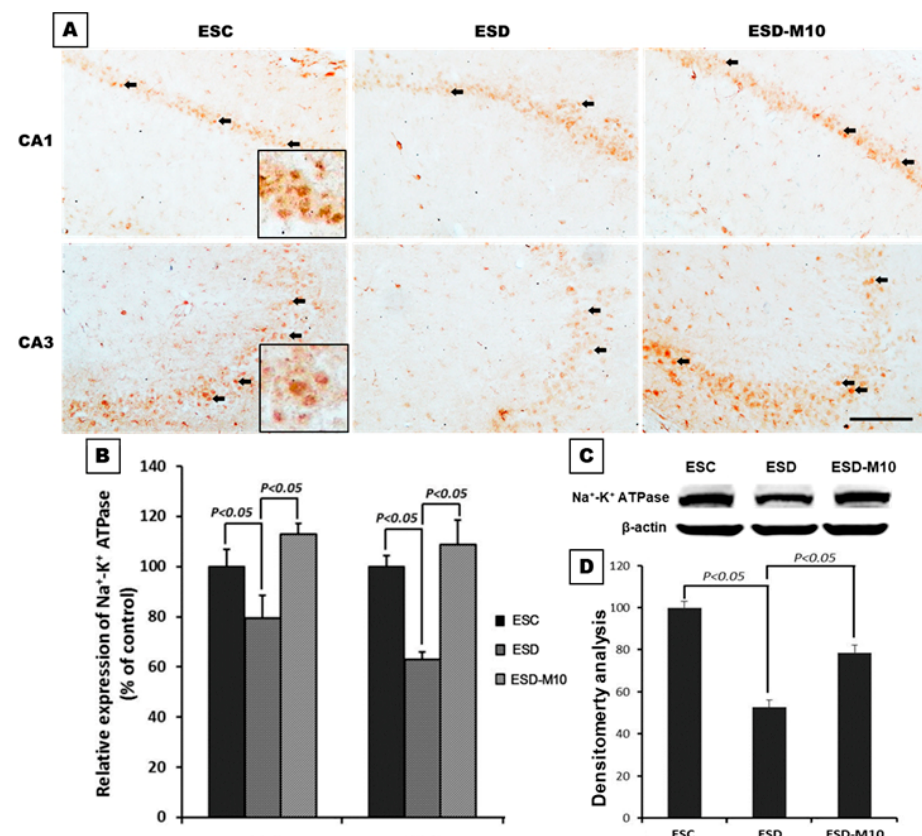
Figure 1. The effects of melatonin on Na + /K + ATPase function. Photomicrographs ( A ) and histogram ( B ) show the extent of Na + /K + ATPase expressions (arrow) in the CA1 and CA3 regions of hippocampus. Note that in ESC group, numerous neurons with strong Na + /K + ATPase expressions were detected in the hippocampus. However, following ESD, remarkable decrease in hippocampal Na + /K + ATPase expression was detected. In ESD-M10 group, hippocampal Na + /K + ATPase expressions were effectively preserved. The immunoblotting data ( C , D ) coincided well with IHC findings in that melatonin effectively improved Na + /K + ATPase activity. Scale bar: 300 μ m.